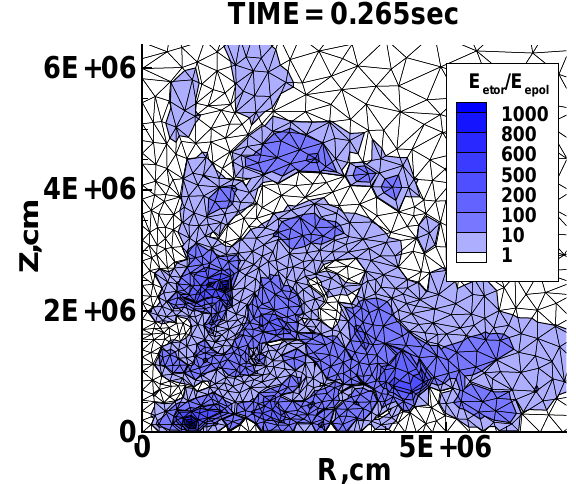
Figure 9: The Lagrangian triangular grid and the ra- tio of the toroidal magnetic energy E tor to the poloidal magnetic energy E pol , E tor at t = 265ms for the case E pol H 0 = 10 9 G , E rot 0 /E grav 0 =